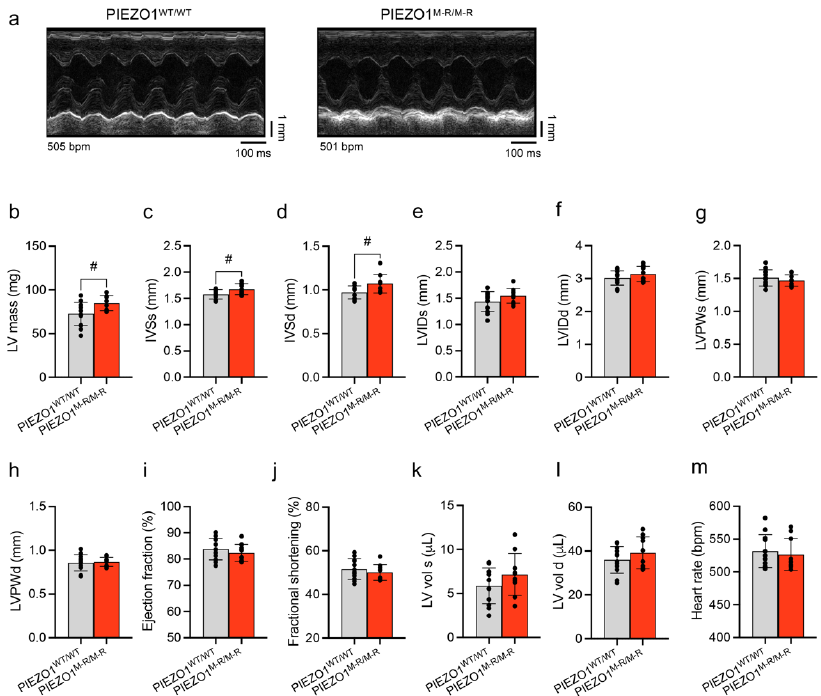
Figure 2. PIEZO1 gain-of-function mutation causes in vivo cardiac hypertrophy. ( a ) Representative echocardiography M-mode images of short axis view in PIEZO1 WT/WT and PIEZO1 M-R/M-R mice. ( b – m ) Parameters obtained from the echocardiograms analysis. ( b ) Left ventricular (LV) mass; ( c ) interventricular septum thickness at end-systole (IVSs); ( d ) IVS in end-diastole (IVSd); ( e ) LV internal diameter in systole (LVIDs); ( f ) LVID in diastole (LVIDd); ( g ) LV posterior wall thickness in systole (LVPWs); ( h ) LVPW in diastole (LVPWd); ( i ) cardiac ejection fraction; ( j ) cardiac fractional shortening; ( k ) LV volume in systole (LV vol s); ( l ) LV vol in diastole (LV vol d); ( m ) heart rate. Data are for n = 12 PIEZO1 WT/WT and 10 PIEZO1 M-R/M-R mice (mean ± S.D.). Superimposed dots represent the individual values for each animal. # p < 0.05 vs. PIEZO1 WT/WT mice. Unpaired Student’s t -test was used to evaluate statistical significance.